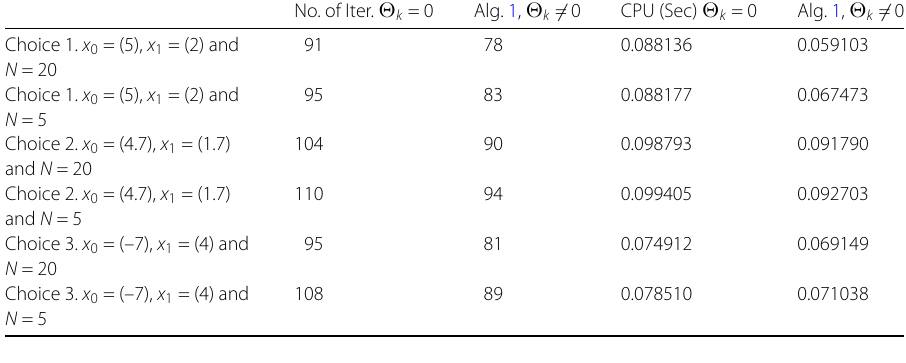
Table 1 Numerical results for Example 4.1